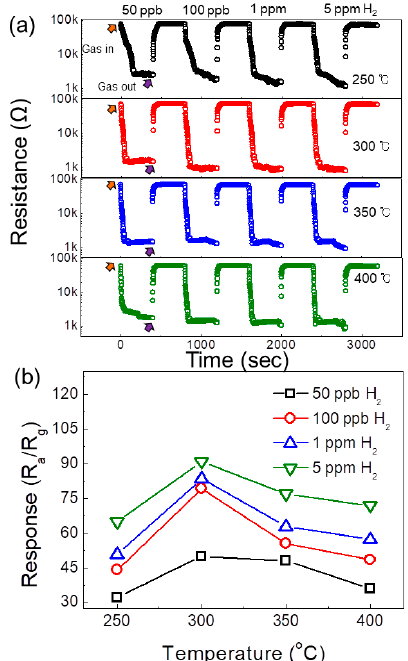
Figure 4. ( a ) Dynamic response curves of 0.1 SnO 2 -loaded ZnO NFs to 50 ppb, 100 ppb, 1 ppm and 5 ppm H 2 gas at different temperatures. ( b ) Calculated hydrogen response as a function of operating temperature.